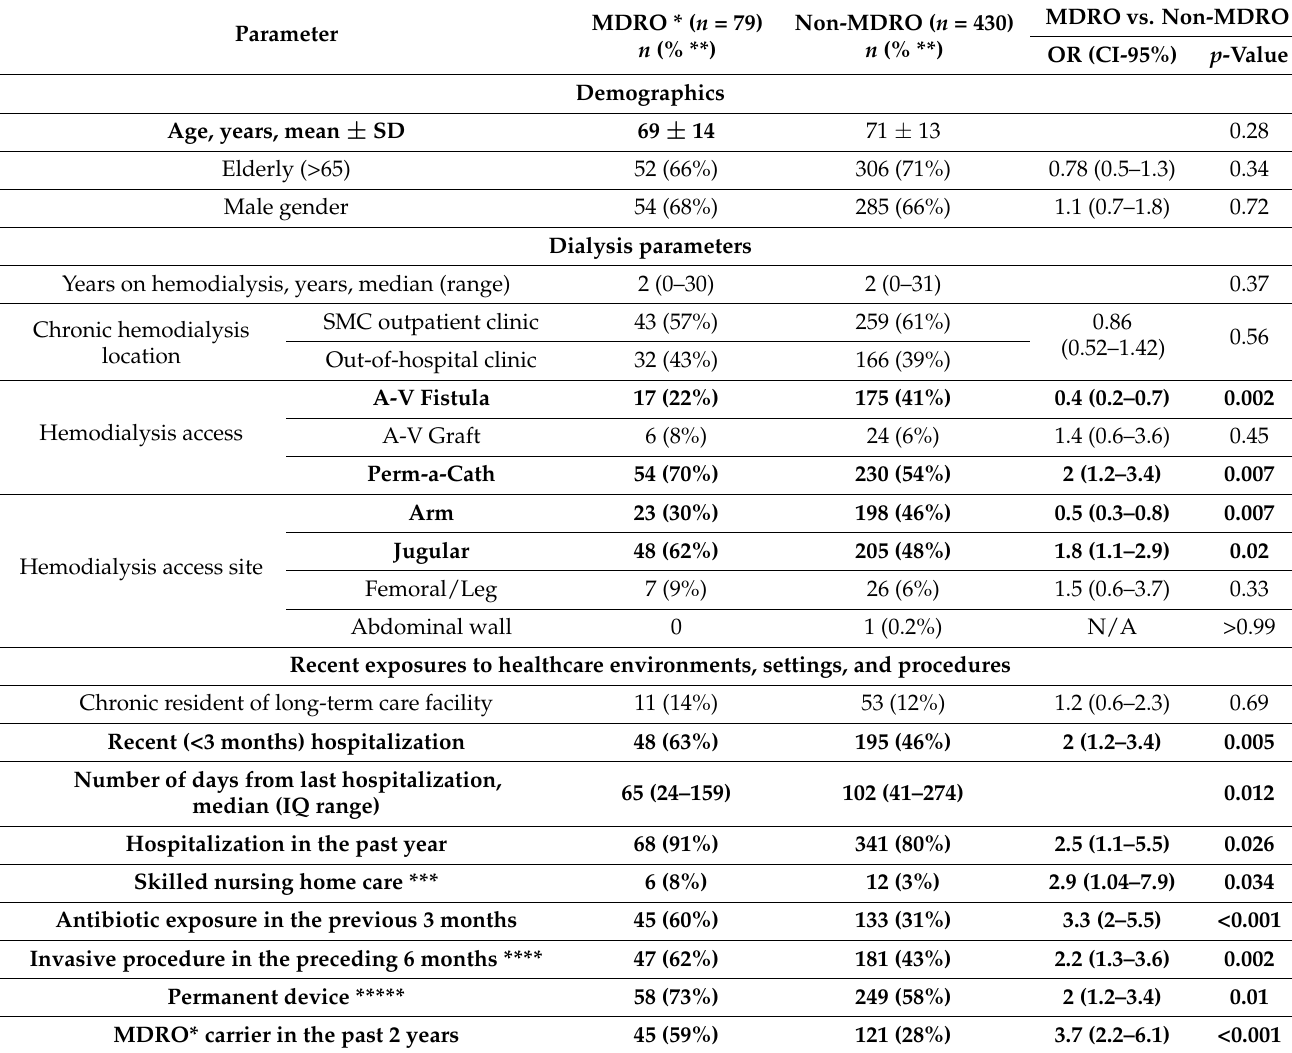
Table 2. Univariable analysis of septic hemodialysis adult patients with multidrug-resistant organism (MDRO) infections versus non-MDRO